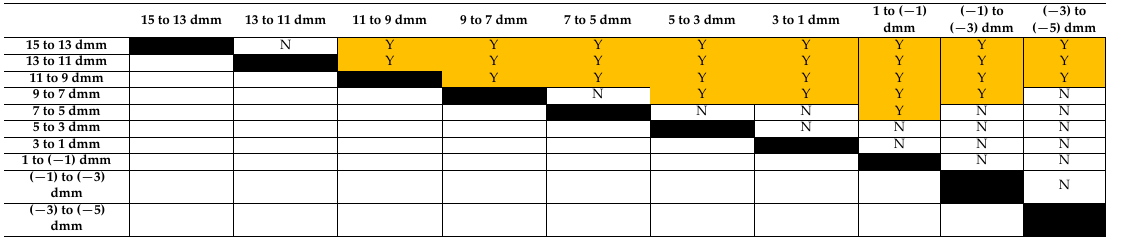
Table 4. Comparison of means differences between diameter of seedlings using Student's t -test (1 dmm is a tenths of a millimeter, 10 − 4 m). Use of contrasts to determine whether there is a significant difference ( p ≤